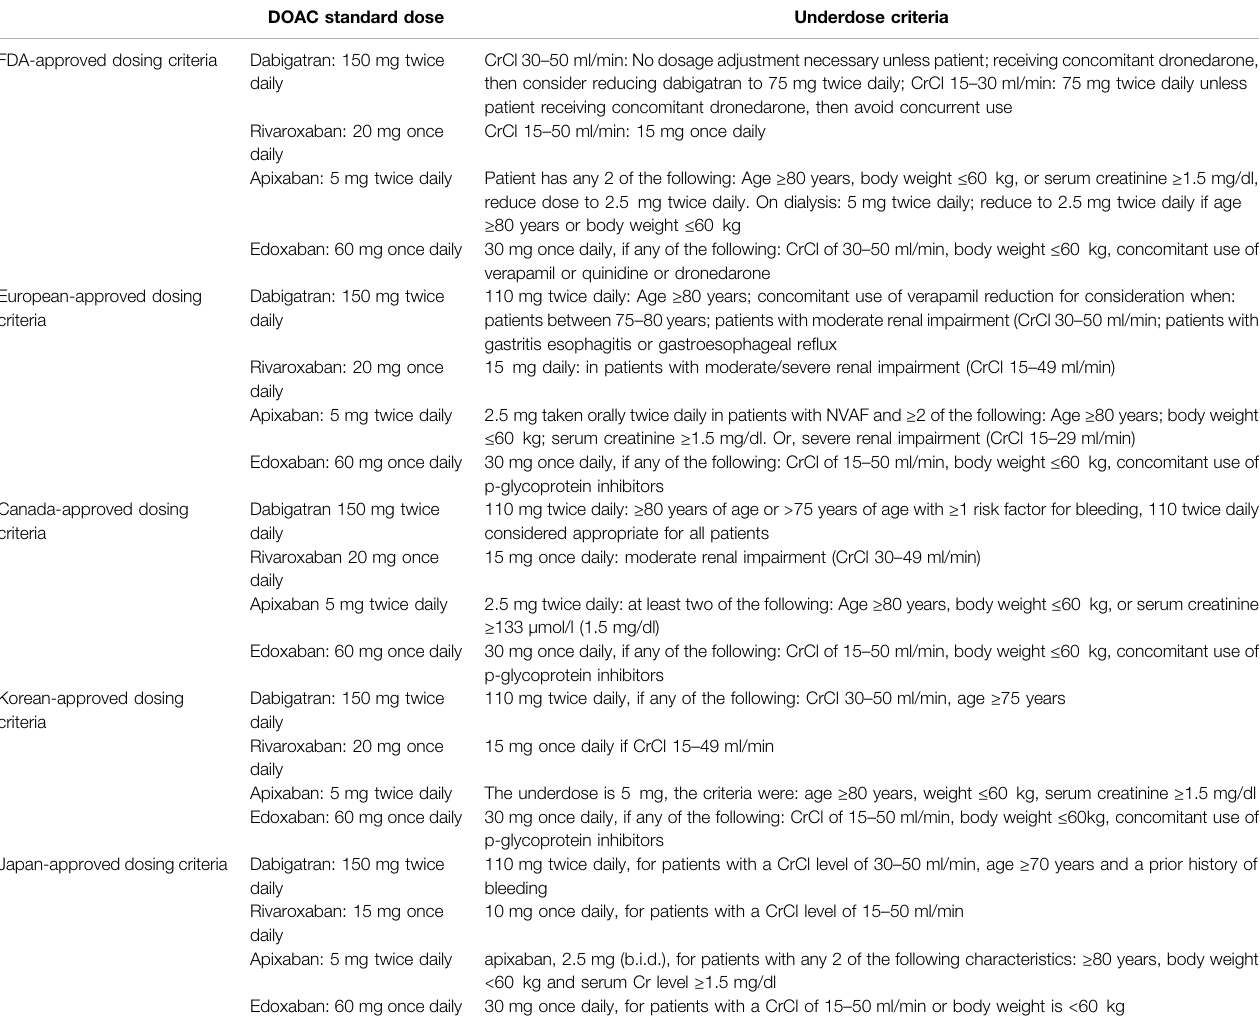
TABLE 1 | Dosing criteria of DOACs in this systematic review. DOAC standard dose Underdose criteria FDA-approved dosing